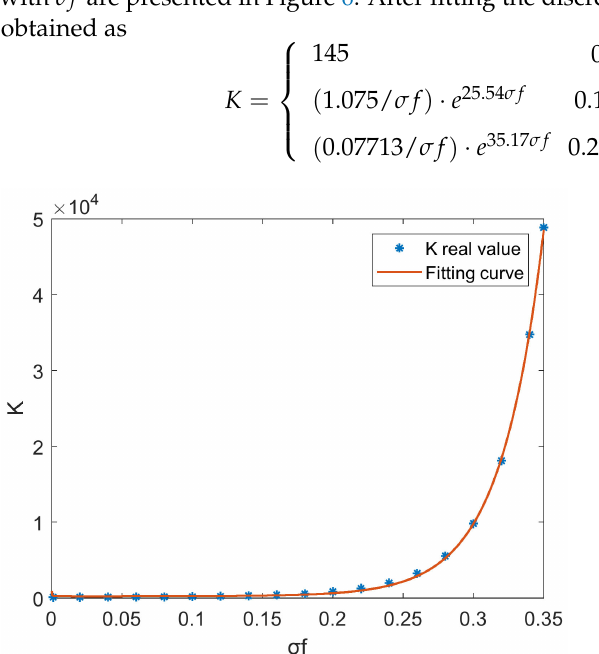
√ 2 π σ V M ( V M is the peak removal rate)